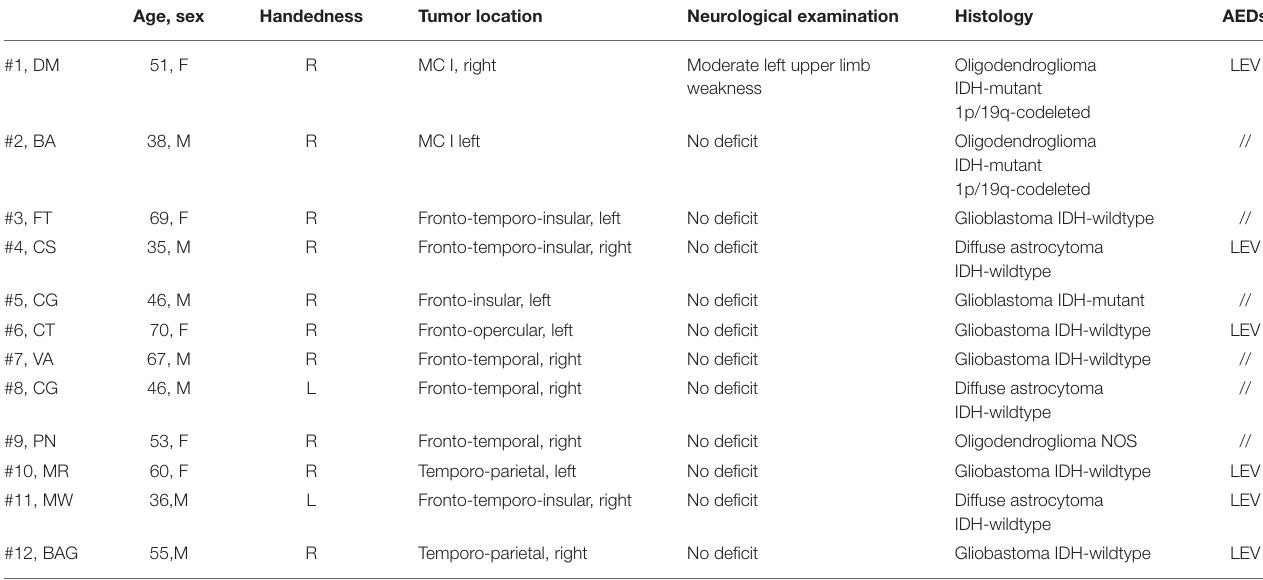
TABLE 1 | Summary of patients’ epidemiological